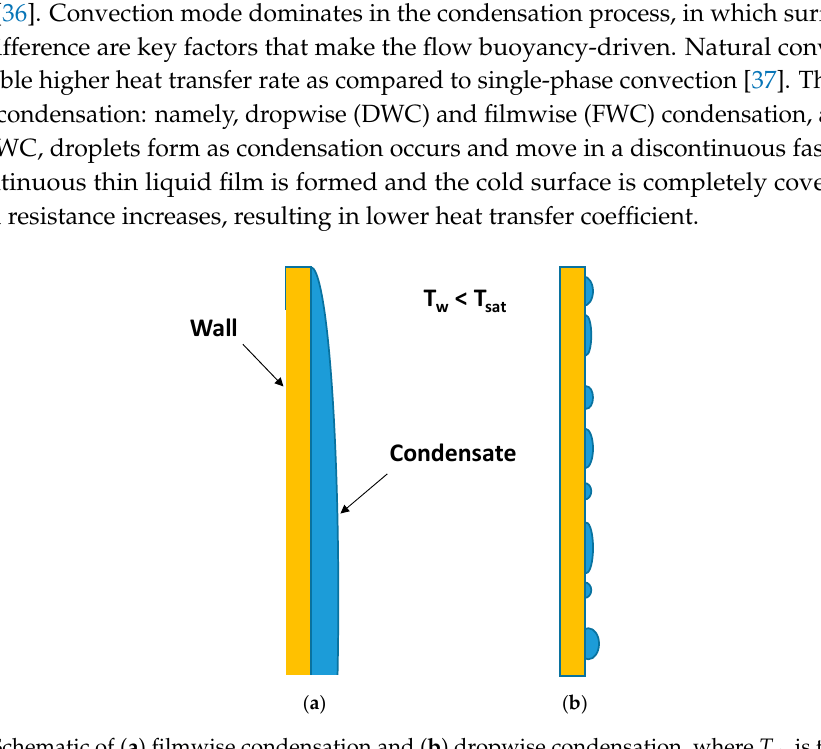
Figure 3. Schematic of ( a ) filmwise condensation and ( b ) dropwise condensation, where T w is the wall temperature and T sat is the saturation temperature of the fluid.